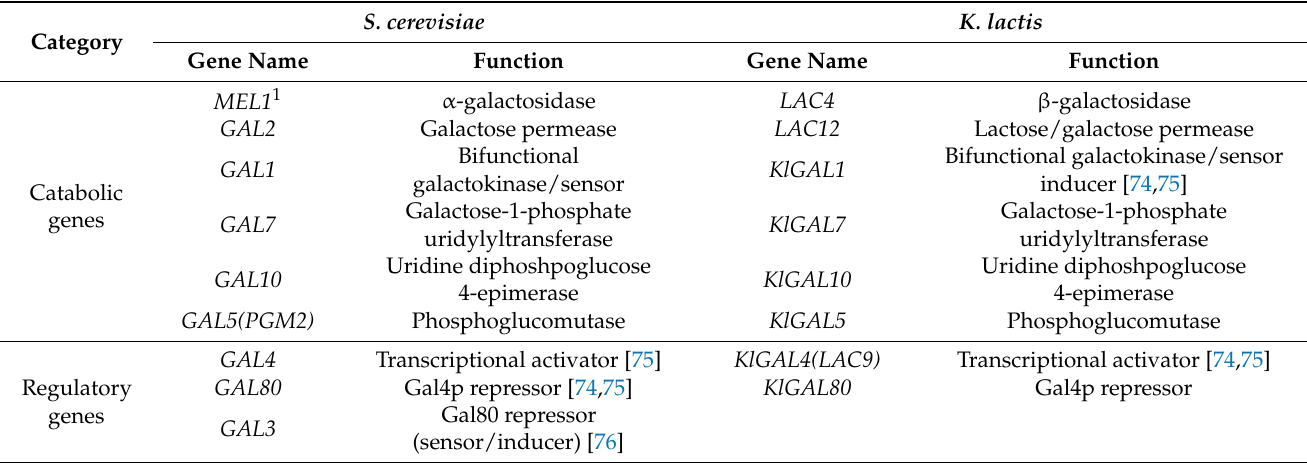
Table 2. Galactose/lactose catabolic and regulatory genes and their respective annotations in S. cerevisiae and K. lactis